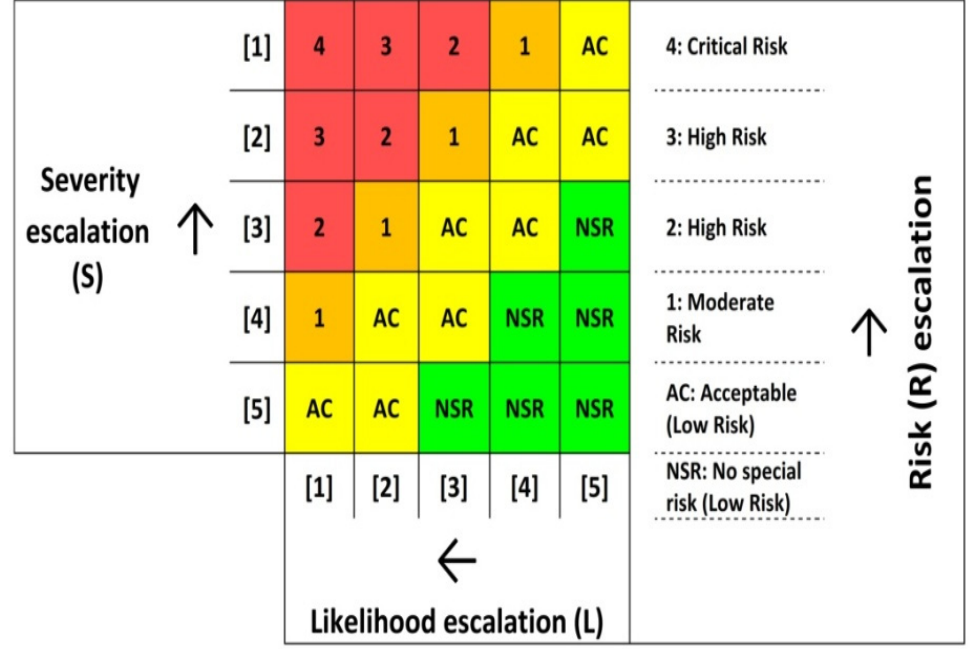
Table 3. Illustration of a risk-matrix based on OSHA’s recommended color coding.